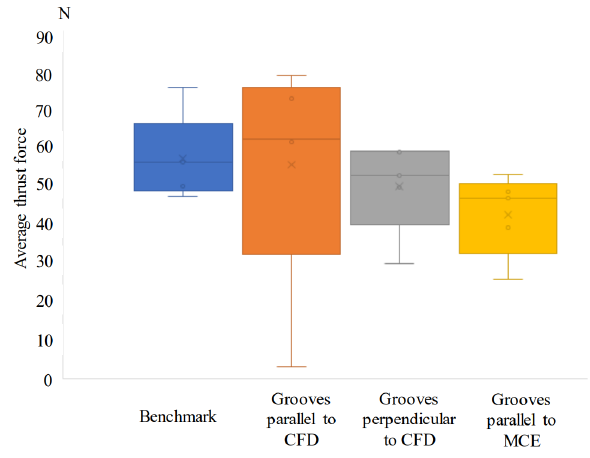
Figure 21. Comparison in average thrust force for benchmark and processed inserts at a cutting length of 873 m [81].